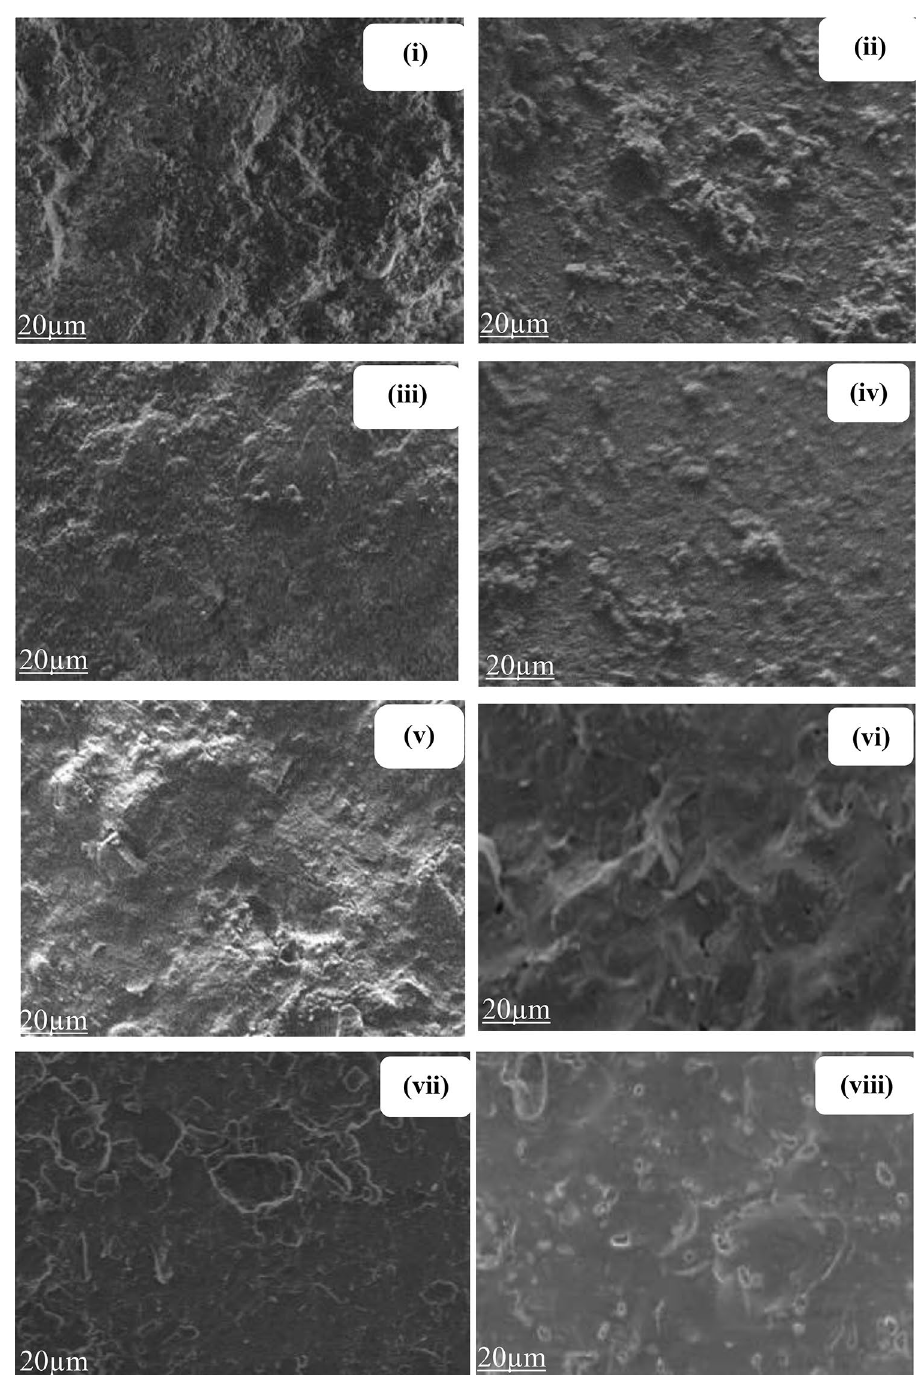
Fig. 7 SEM micrographs of clay bricks (i-ii) 0 wt% of granite powder, (iii-iv) 10 wt% of gran- ite powder, (v-vi) 20 wt% of granite powder and (vii-viii) 30 wt% of granite powder fired at 900 °C and 1100 °C for 2